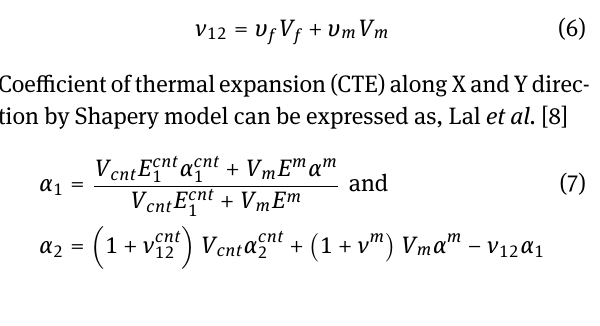
Figure 2: Variation of axially variable inplane buckling load